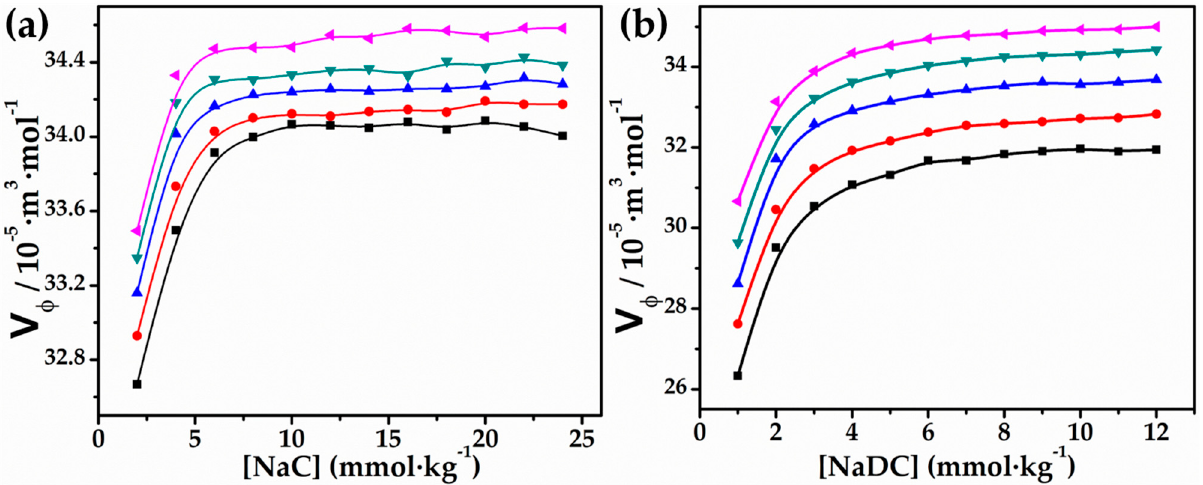
Figure 1. Plots of φ V vs. ( a ) [NaC] and ( b ) [NaDC] in 0.010 mol ∙ kg –1 aqueous solution of glycyl Figure 1. Plots of V ϕ vs. ( a ) [NaC] and ( b ) [NaDC] in 0.010 mol · kg − 1 aqueous solution of glycyl glycine at 293.15 K ( (cid:4) ), 298.15 K ( • ), 303.15 K ( (cid:78) ), 308.15 K ( (cid:72) ), and 313.15 K ( (cid:74) glycine at 293.15 K ( ■ ), 298.15 K ( ● ), 303.15 K ( ▲ ), 308.15 K ( ▼ ), and 313.15 K ( ◄ ).